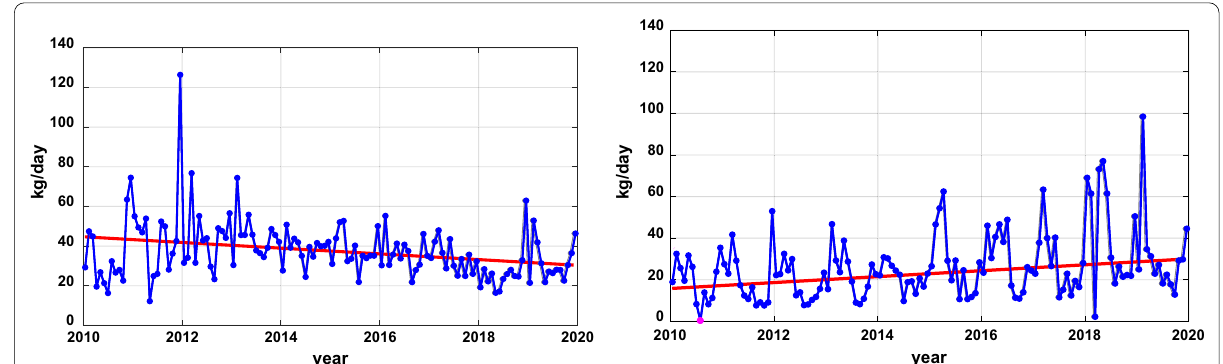
Fig. 1 Trends in the daily loads (kg/day) of Diatrizoic acid (left) and Iohexol (right) in the